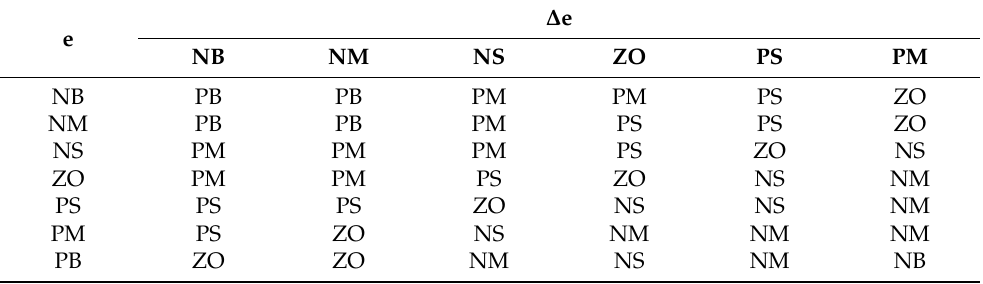
Figure 4. Fuzzy-active disturbance rejection controller. Table 1. Fuzzy control rule